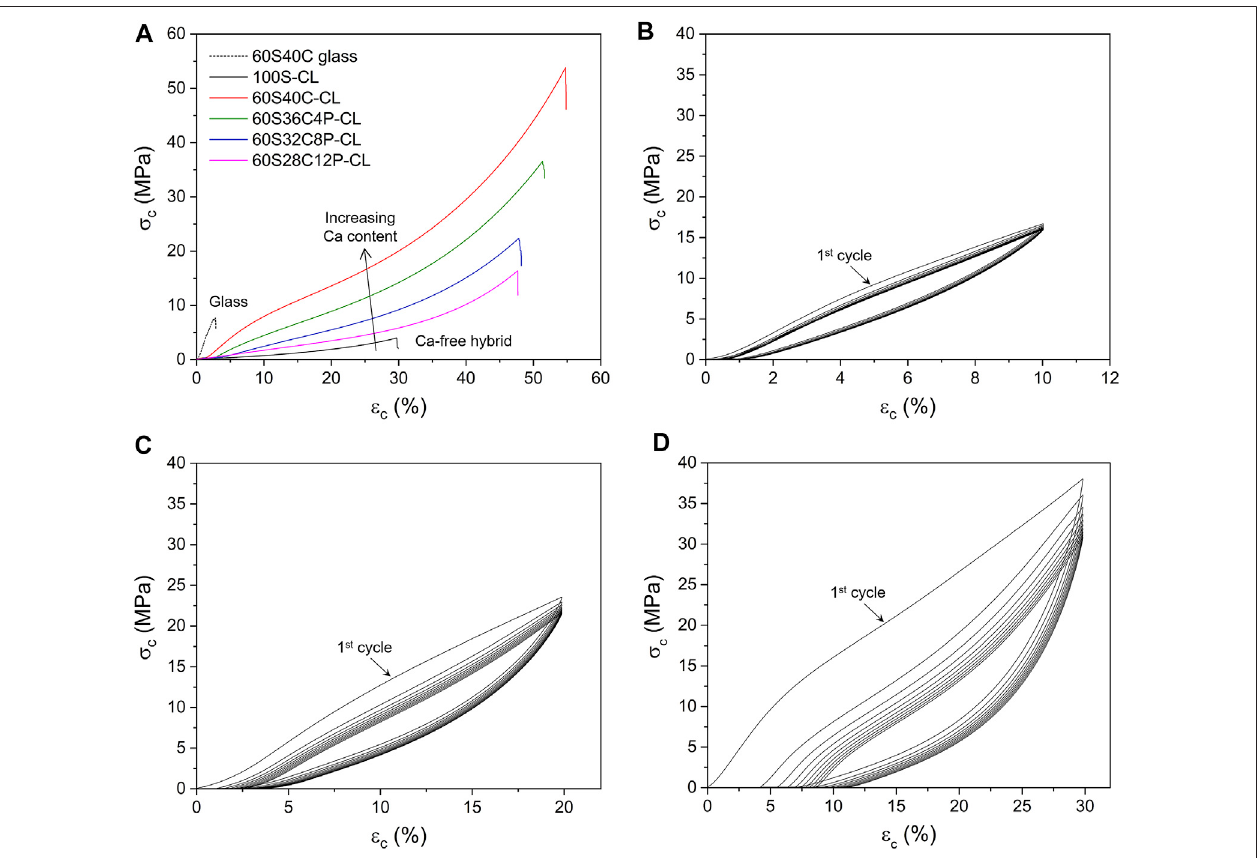
FIGURE 4 | Compression testing of SiO 2 -CaO-P 2 O 5 /PTHF/PCL-diCOOH hybrid monoliths: (A) Example conventional stress-strain curves to failure, comparing the four Ca-containing hybrid samples with pure 60S40C (60 mol% SiO 2 , 40 mol% CaO) glass and Ca-free hybrid (B – C – D) Example cyclic testing curves for 60S40C- CL (SiO 2 -CaO-/PTHF/PCL-diCOOH) hybrid monoliths compressed up to 10% (B) , 20% (C) and 30% (D) of their initial height.